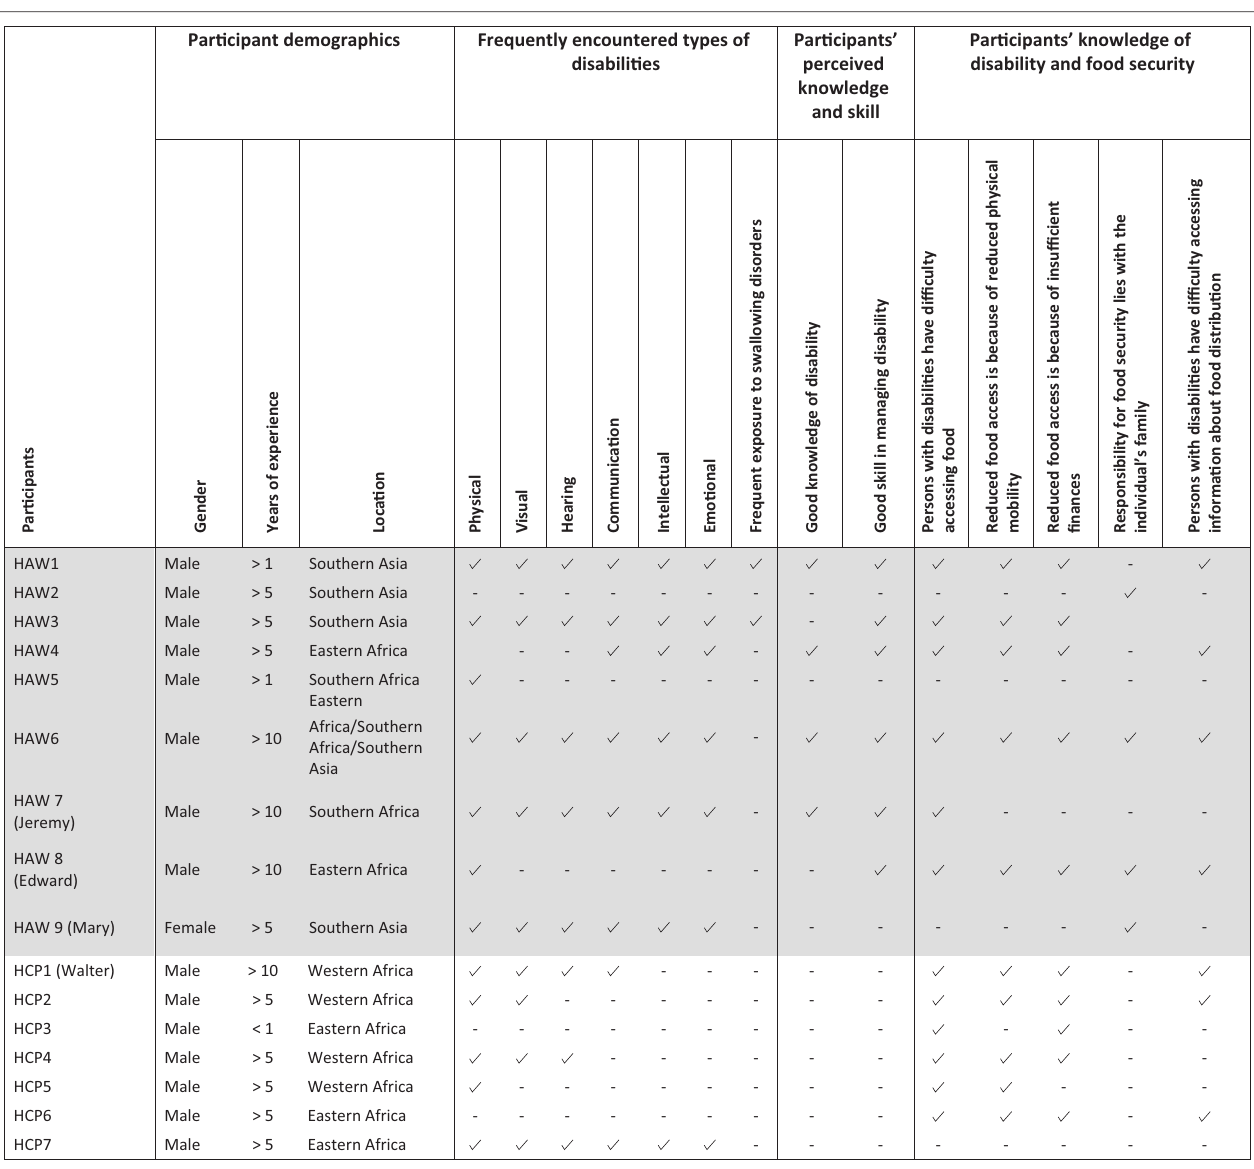
FIGURE 2: Summary of study